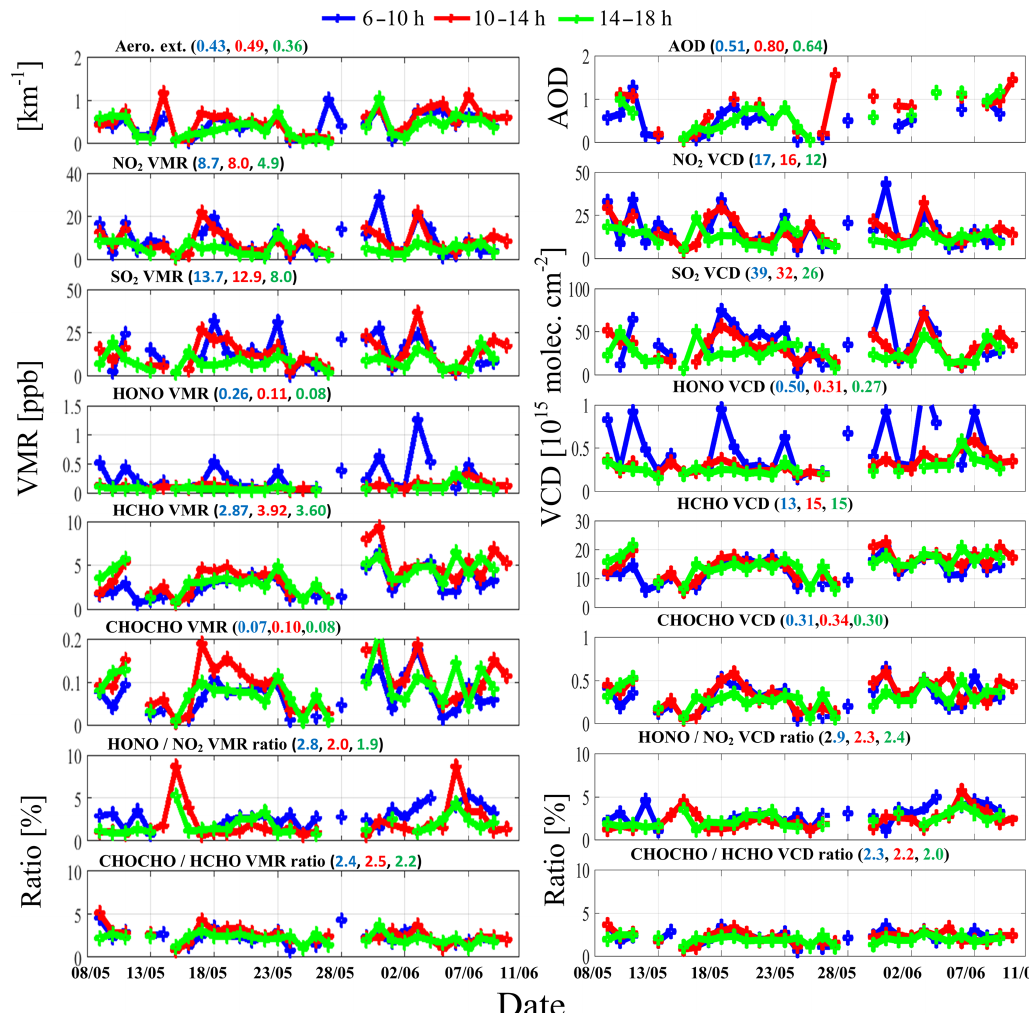
Figure 5. Daily averaged (for three different periods of the day) near-surface aerosol extinction and trace gas VMRs (left), and AODs and trace gas VCDs (right) for the whole campaign. The blue, red and green colours indicate results for the time periods of 06:00–10:00, 10:00– 14:00 and 14:00–18:00, respectively. The ratios of HONO versus NO 2 and CHOCHO versus HCHO are also given for the near-surface VMRs (left) and VCDs (right). The colour-coded numbers in the brackets on the top of each subfigure give the averaged values for the different daily